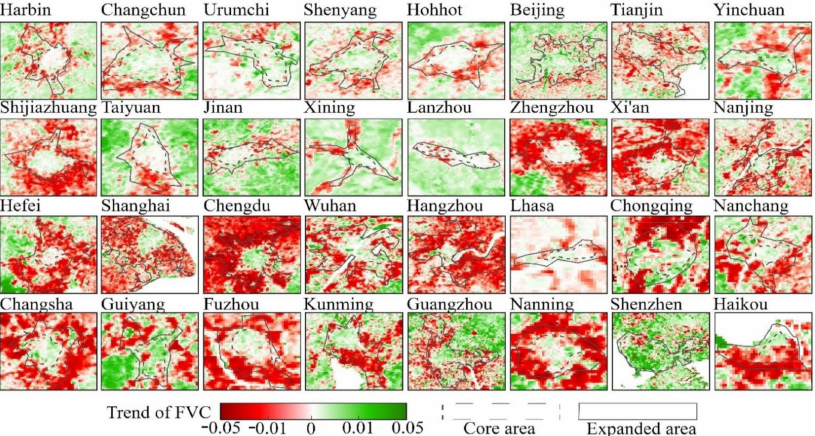
Figure 4. Spatial distribution of FVC trends in 32 major cities in China from 2001 to 2018, with dotted lines representing the boundaries of core areas and solid lines representing the boundaries of extended